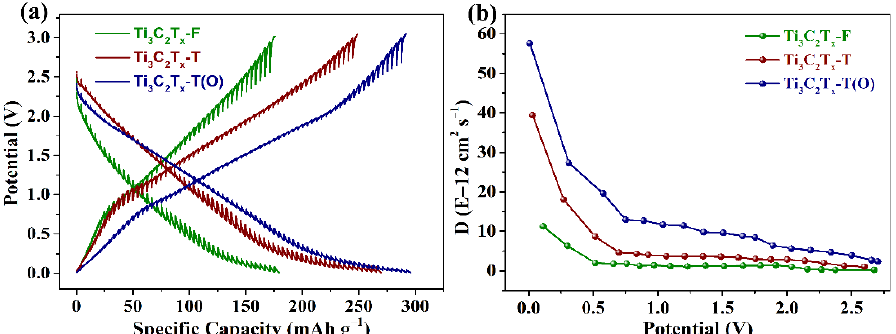
Figure 7. ( a ) GITT results and ( b ) diffusion coefficient for Ti 3 C 2 T x -F, Ti 3 C 2 T x -T, and Ti 3 C 2 T x -T(O) anodes at different potentials.